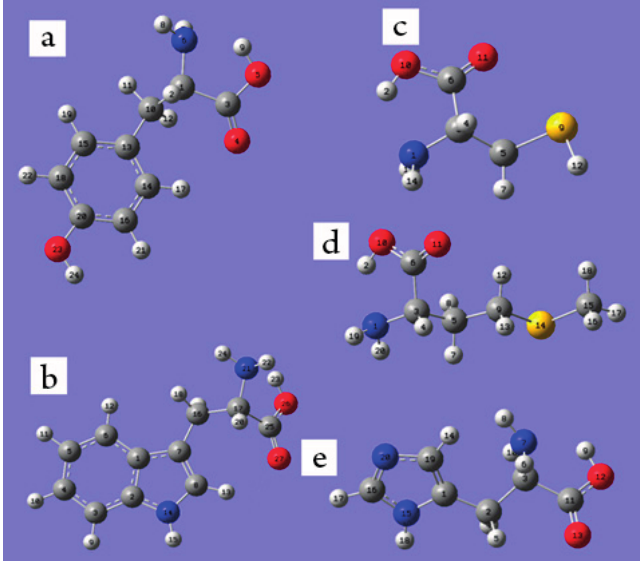
Figure 6. Three-dimensional structures of the redox-active L -amino acids in the gas phase-Tyr ( a ); Trp ( b ); Cys ( c ); Met ( d ); His ( e ). The C atoms are shown as grey, H—white, O—red, N—blue, S—yellow.